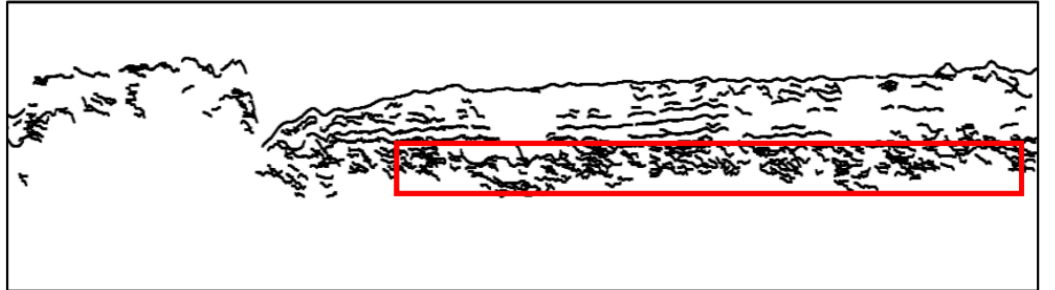
Figure 11. The main horizons obtained without enhancement filtering. Red rectangle shows the discrete and wrong horizons.